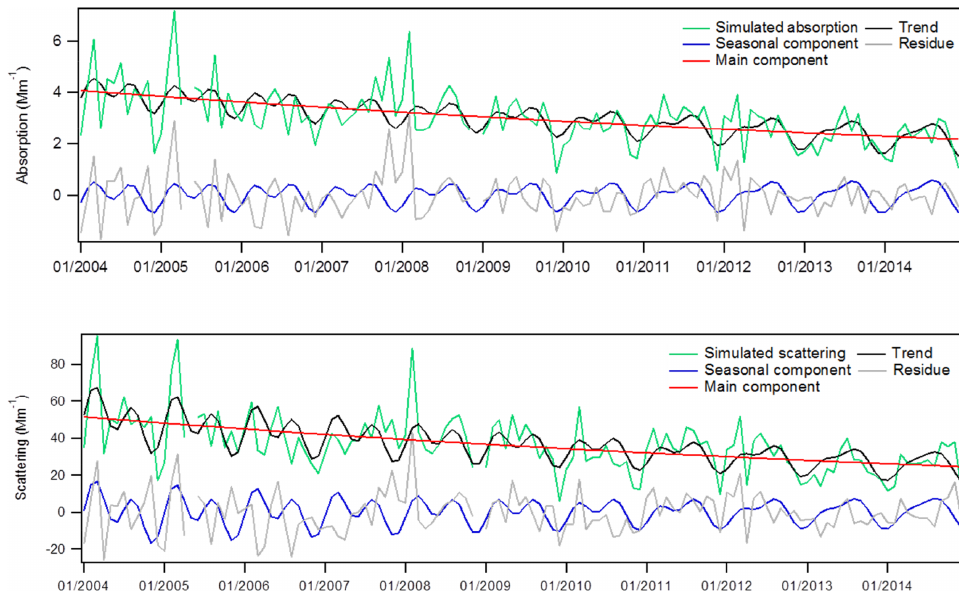
Figure 8. Temporal trends for the monthly average absorption at 637nm and scattering at 525nm obtained by means of the multi-exponential test at MSY during the period 2004–2014. The time series were decomposed into simulated coefficient (green), trend (red), main component (black), seasonal component (blue) and residue